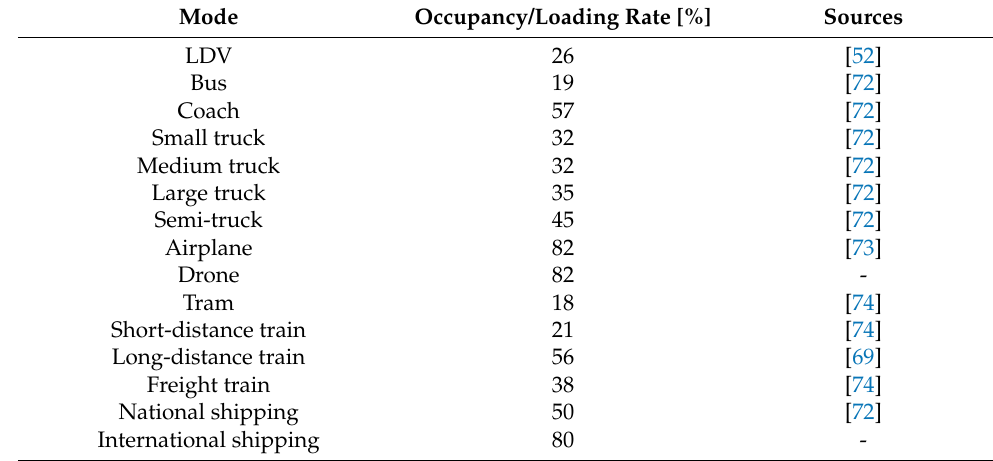
Table 3. Default occupancy rates for the different modes